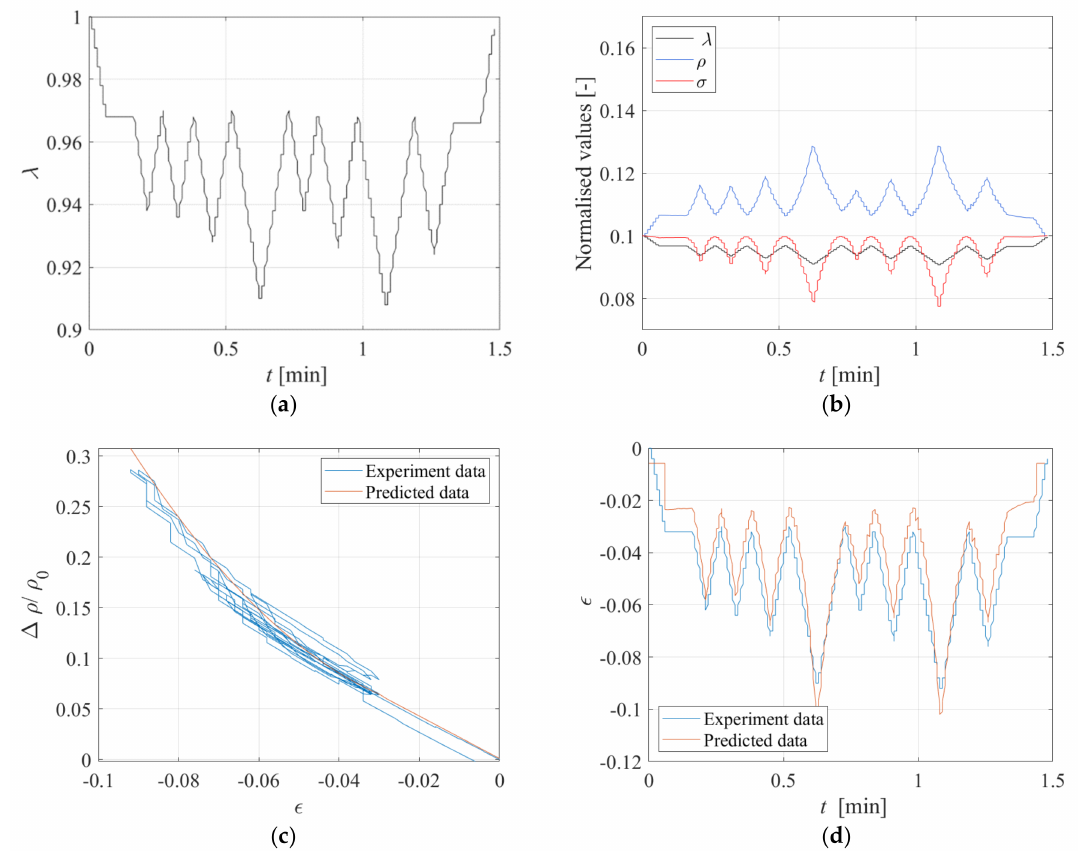
Figure 26. ( a ) Input random, ( b ) Time history of normalised displacement, stress, and electrical resis- tance under the displacement input of Figure 26a. Comparison between experiment and predicted data: ( c ) Variation of resistivity vs. strain, and ( d ) Strain vs.